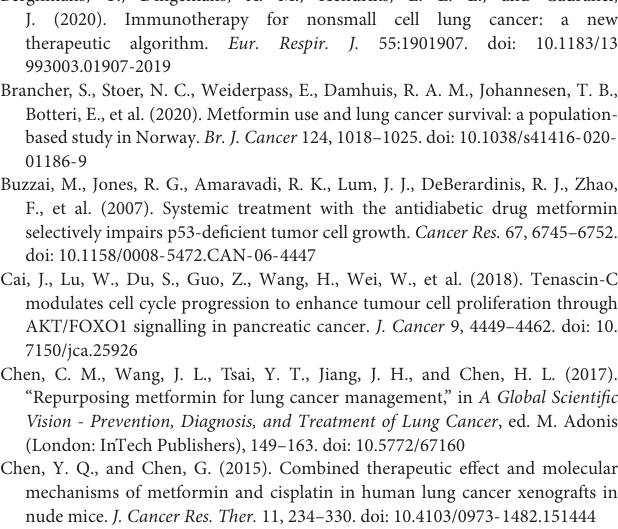
Supplementary Figure 1 | Whole western blot images with densitometry readings. (A–H) Whole western blot images with all molecular weight markers depicted in Figure 3A . Molecular weight markers are indicated. The intensity values and calculated ratios of each targeted band of the Western blots depicted in (A–H) . Supplementary Figure 2 | All IVIS images of whole animals and isolated lungs used within the main text of Figure 5